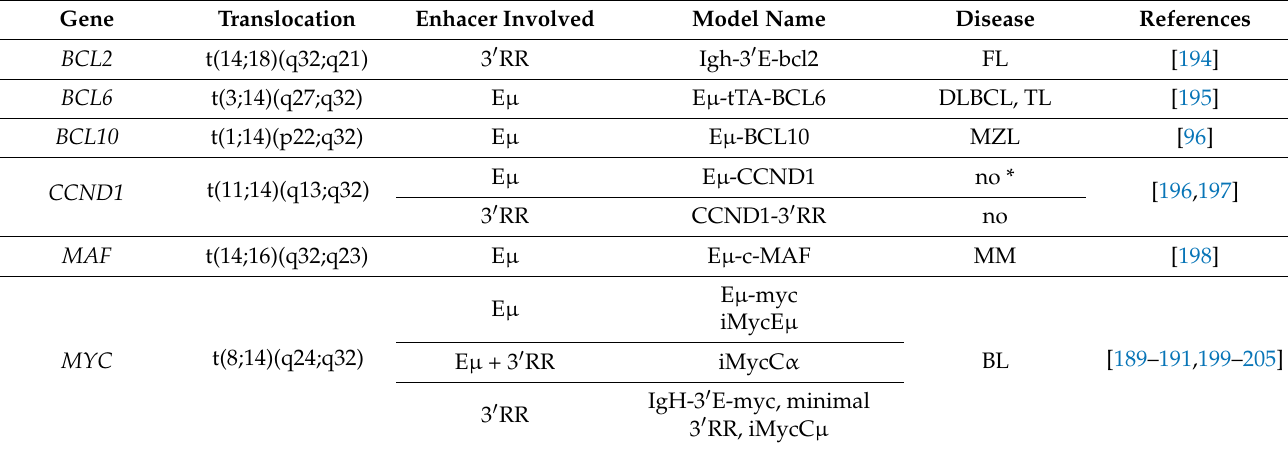
Table 2. Mouse models— IGH